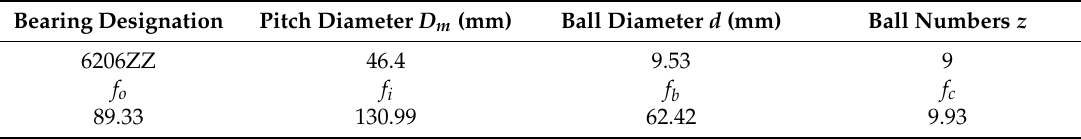
Figure 9. The motor bearing test rig. Table 3. The parameters of the motor bearings.